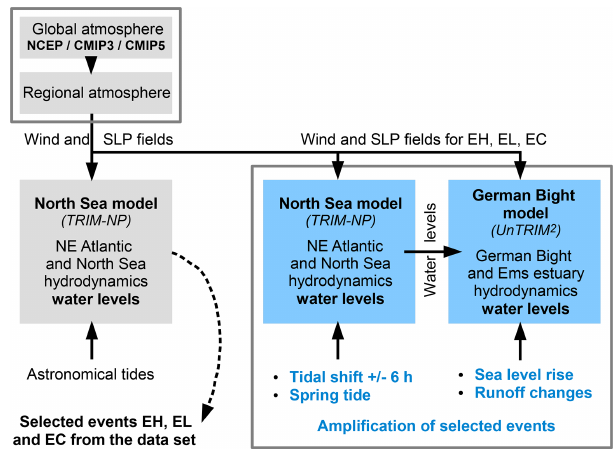
Figure 2. Scheme of the chain of models and simulations for the selected events and their